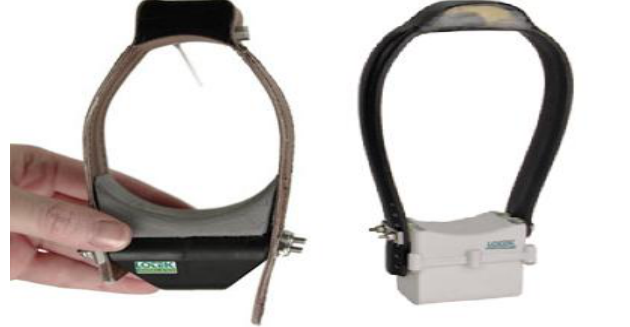
Figure 7. GPS collars: ( Left ), GPS collar designed for small mammals, ( Right ) GPS collar designed from medium-large sized mammals (Images provided by Lotek Wireless Inc.